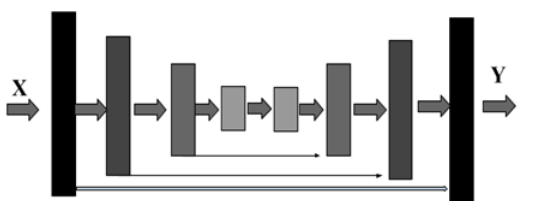
Figure 4: UNET architecture with skip connections that